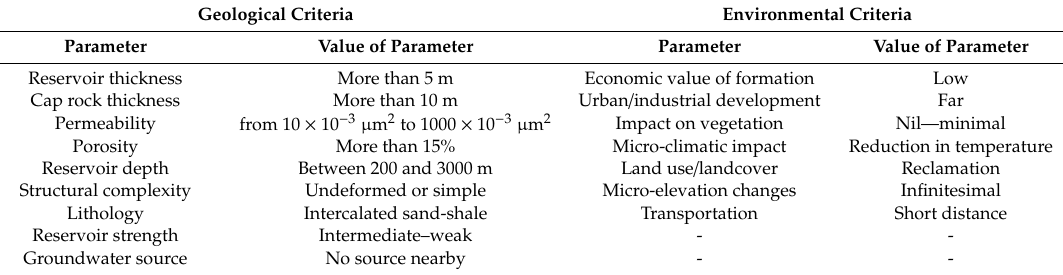
Table 6. Criteria for site suitability of an slurry fracture injection operation